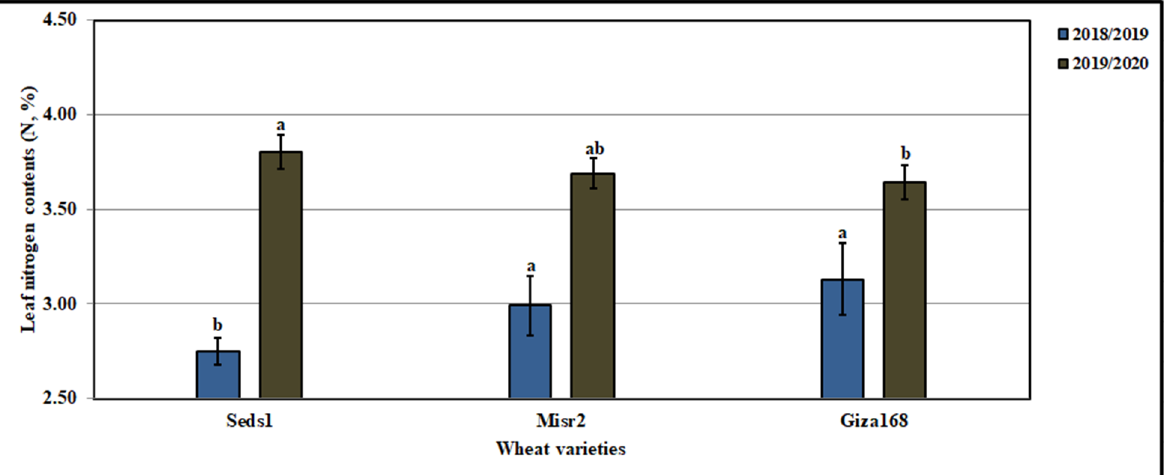
Figure 22. Influence of wheat varieties on leaf nitrogen contents (N, %) in clay loam soil in 2018/2019 and 2019/2020 seasons. Bars in the same years with a different letter indicate significant differences between treatments at p ≤ 0.01. HS 1, HS 2 , HS 3 represent HS applied as foliar spray at 1.0, 2.0, 4.0 g L − 1 , respectively, HS 4 , HS 5 , HS 6 represent HS applied as soil application at 5.04, 7.56, 10.08 kg ha − 1 .